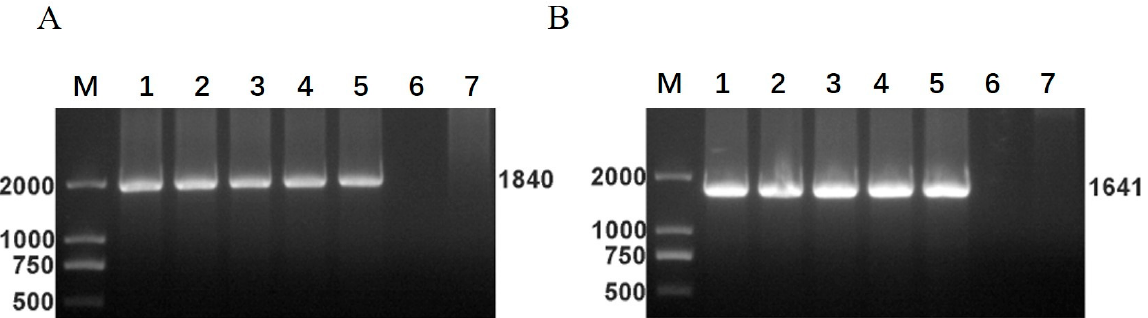
Figure 7. Genetic stability of the recombinant viruses rSRV9-H and rSRV9-F. The P3, P6, P9, P12, and P15 generations of recombinant RABV rSRV9-H and rSRV9-F were used for PCR identification.